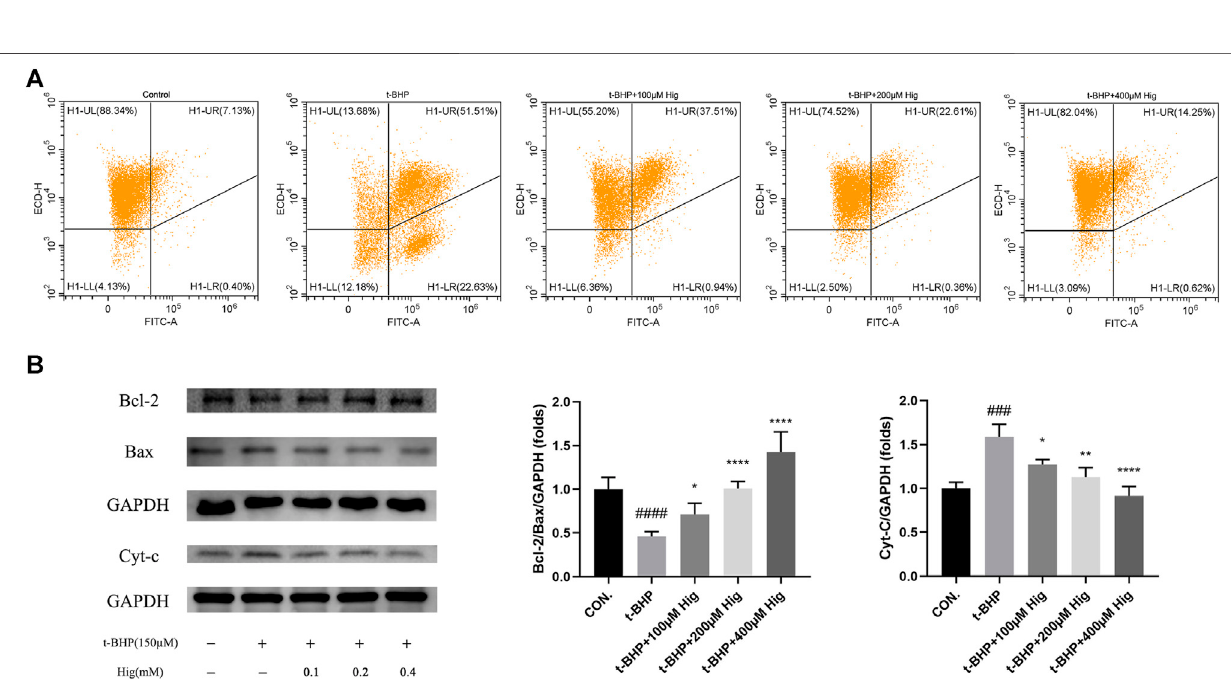
Frontiers in Pharmacology |